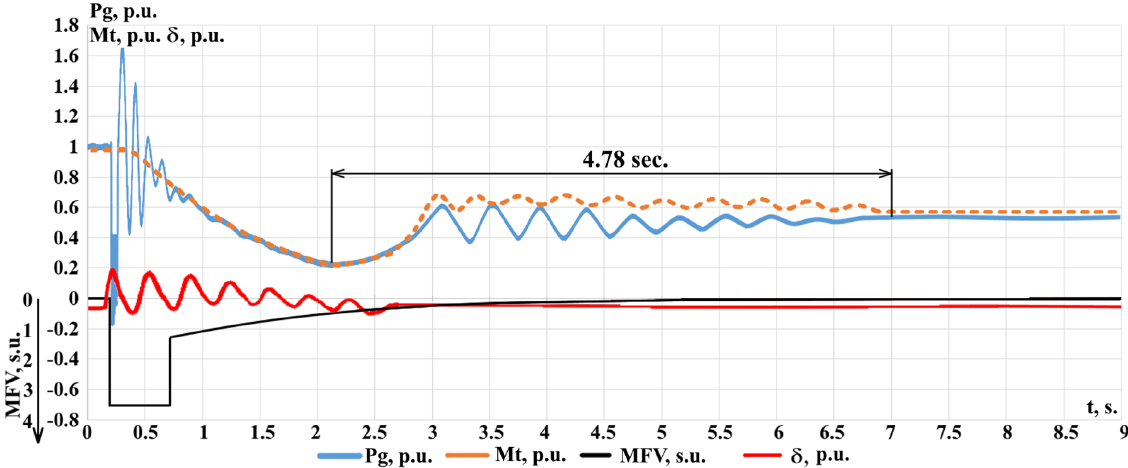
Figure 19. Generator G 2 active power, turbine torque, and angle for the Case 1.